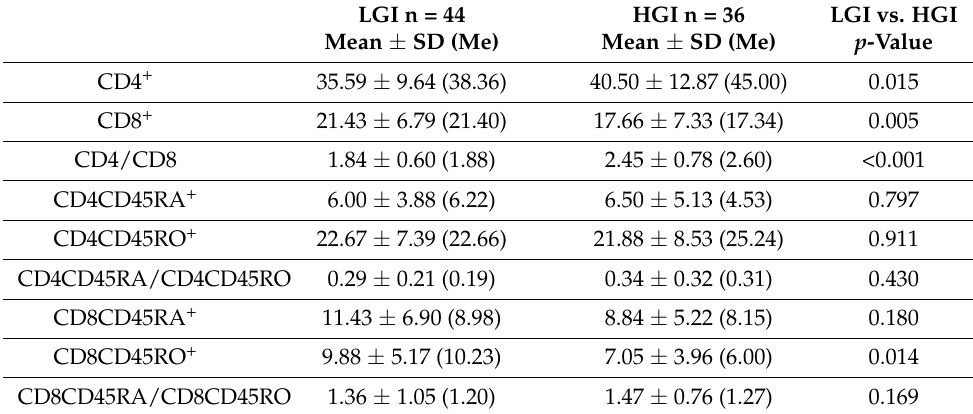
AUC, area under the curve, cut-off value, and the optimal threshold value for clinical stratification.